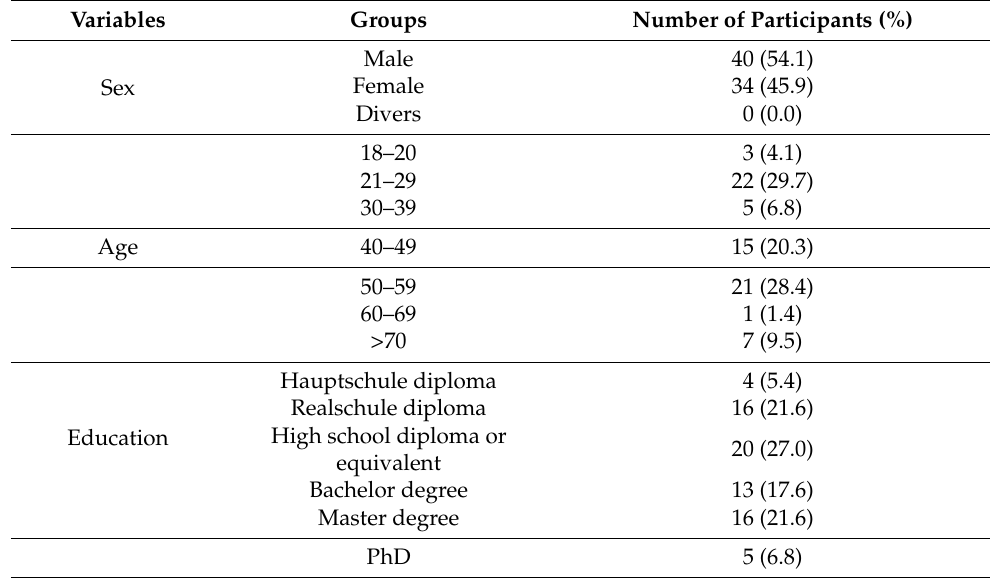
Table A1. Personal information of the participants of the first